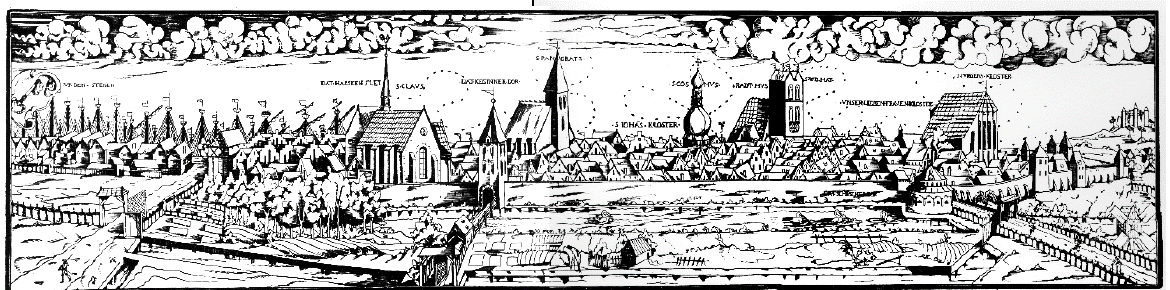
Figure 6. View of the town of Stade in the year 1550, after a woodcut by Martin Weigel (Wirtgen, Bohmbach,